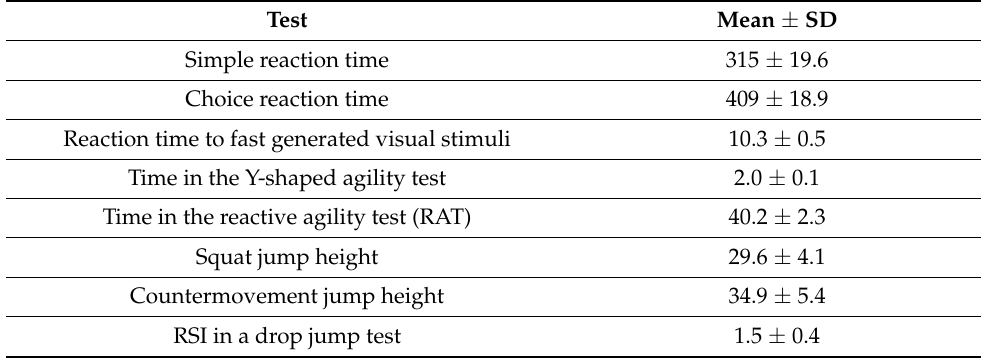
Table 1. Descriptive statistics of handball player test performance.